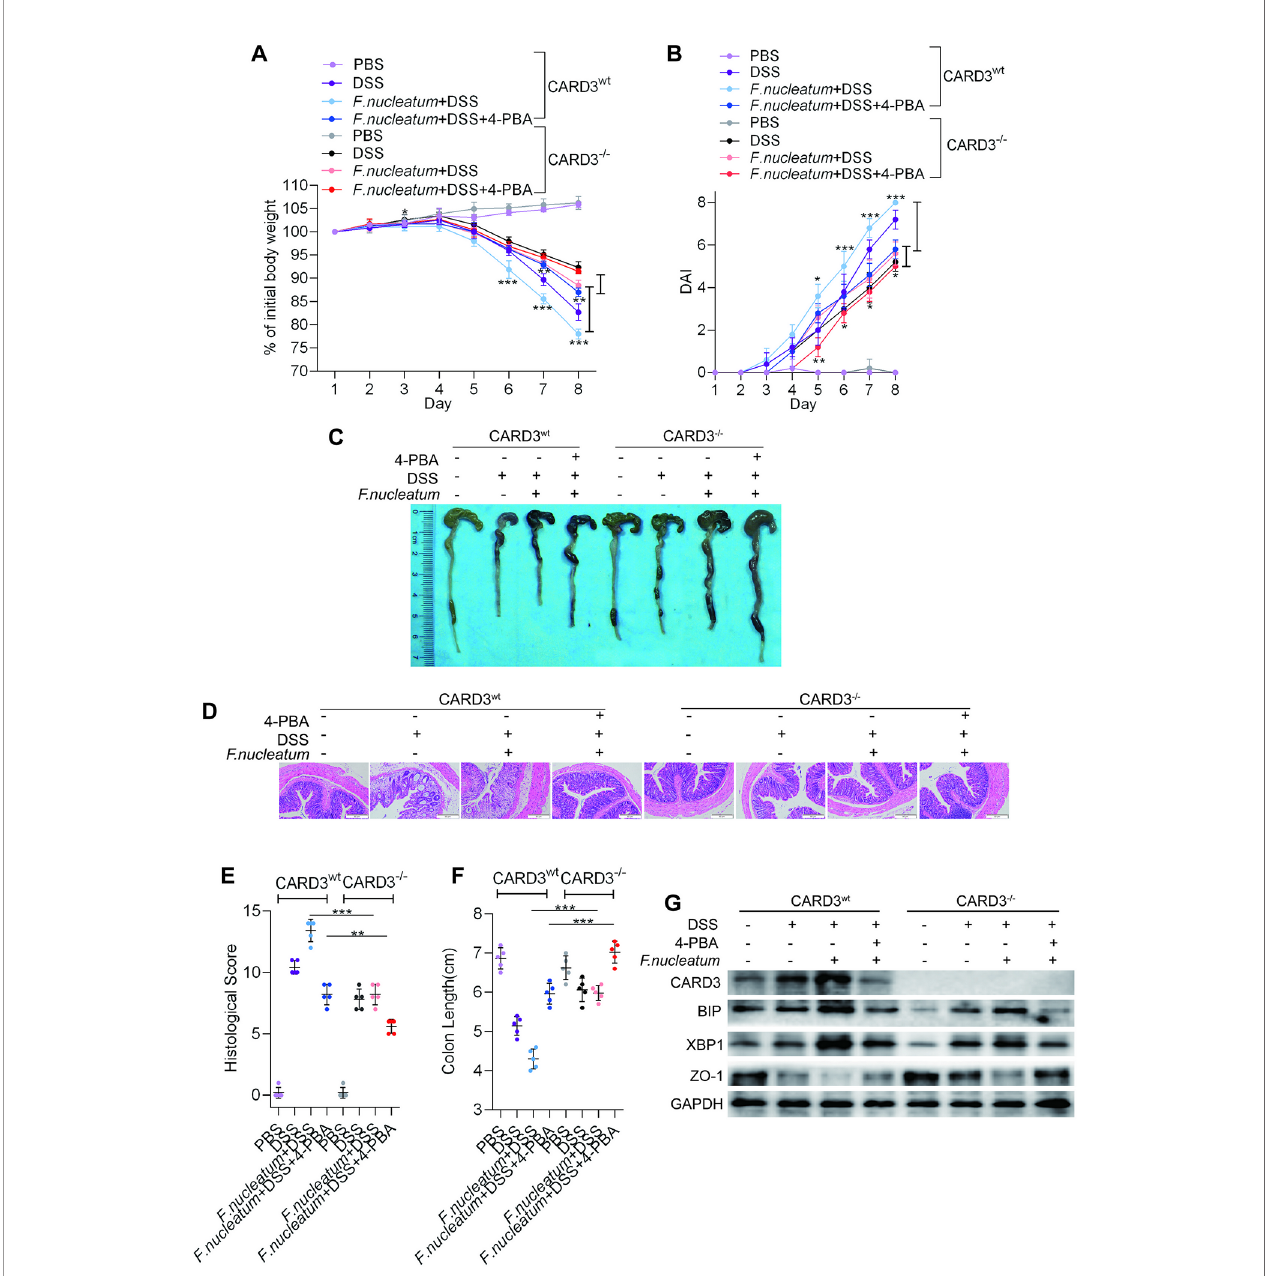
FIGURE 6 | Fusobacterium nucleatum activates the endoplasmic reticulum (ER) pathway through the upregulation of caspase activation and recruitment domain 3 (CARD3) in dextran sulfate sodium (DSS)-induced mice. (A – F) CARD3 wt mice and CARD3 – / – mice (n=5 per group) were administered intraperitoneal injections of 4- phenyl butyric acid (4-PBA) and treated with F. nucleatum or phosphate-buffered solution (PBS) for 2 weeks. Then, these mice were administered DSS along with continued 4-PBA treatment for an additional 7 days. Colitis induction was evaluated by body weight loss (A) and the disease activity index (DAI) (B) . (* P < 0.05, ** P < 0.01, and *** P < 0.001; one-way ANOVA combined with Bonferroni ’ s post hoc test; the error bars indicate the SDs). Representative colon morphology and length in the mice are shown in panel (C) and quanti fi ed in panel (F) . Representative images of histological analyses are shown in panel (D) and quanti fi ed in panel (E) (* P < 0.05, ** P < 0.01, *** P < 0.001, and **** P < 0.0001; unpaired Student ’ s t test; the error bars indicate the SDs; 200× magni fi cation). (G) Western blotting was performed to measure the levels of CARD3, BIP, XBP1, and ZO-1 in colon tissues from